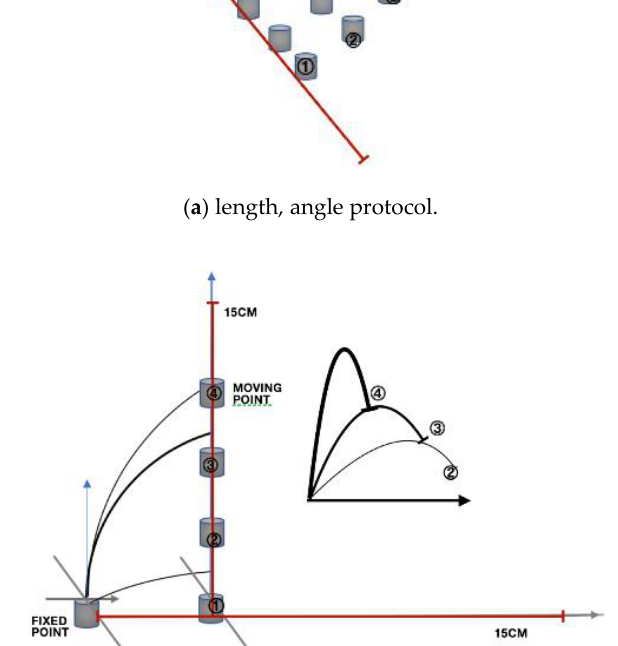
Figure 6. ( a ) Experimental measurement device with a length unit of 1 cm and an angle unit of 10°. ( b ) A diagram of the experimental measurement device for measuring the maximum and minimum values. Each fixed position and moving position were selected, and rubber tabs for the fixed optical axis were installed at both ends of the sensor.